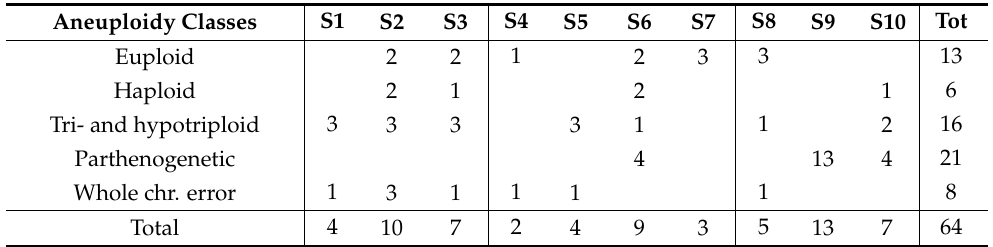
Table 2. Number of blastocysts per sow (S1–S10) according to the aneuploidy classes. Embryos were produced during three IVP rounds which are indicated between borders.